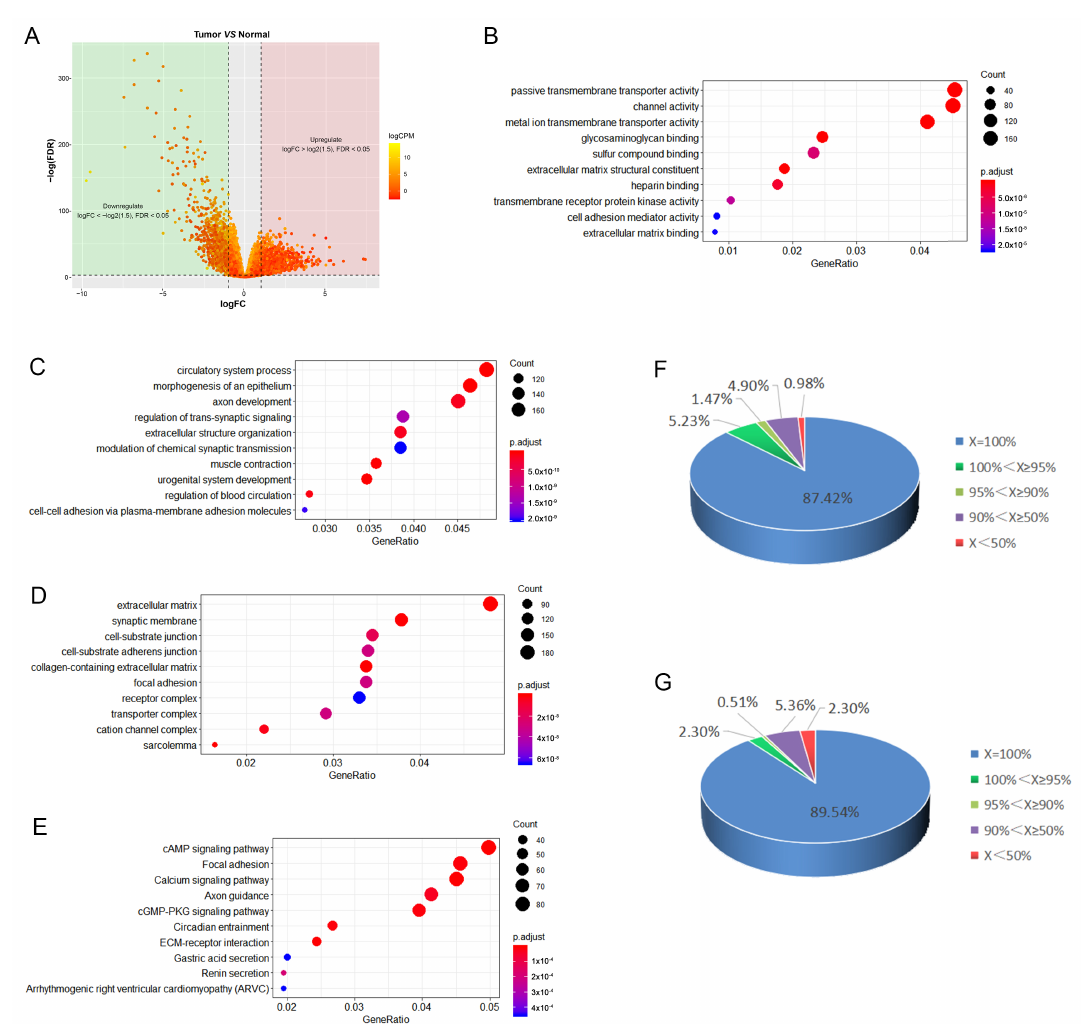
Figure 1. ( A ) Volcano plot of differential gene expression analysis in PCa compared with normal tissue (fold change ≥ 1.5; p -value < 0.05); ( B ) GO biological process, molecular function enrichment analysis; ( C ) GO biological process, biological process enrichment analysis; ( D ) GO biological process, cellular component enrichment analysis; ( E ) KEGG pathway enrichment analysis. The gene ratio in the figure indicates the ratio of the number of differentially expressed genes containing the annotation to the number of differentially expressed genes; ( F ) proportion of lncRNAs across the different percentages of positively correlated mRNA; distribution of 612 lncRNAs across the different percentages of positively correlated mRNA. X = number of positively correlated mRNA/total number of correlated mRNAX100%; ( G ) proportion of lncRNAs across the different percentages of positively correlated mRNA; distribution of 392 lncRNAs acting as potential third strand of potential triplex sites (PTSs) across the different percentages of positively correlated mRNA; X = number of positively correlated mRNA/total number of correlated mRNA ×